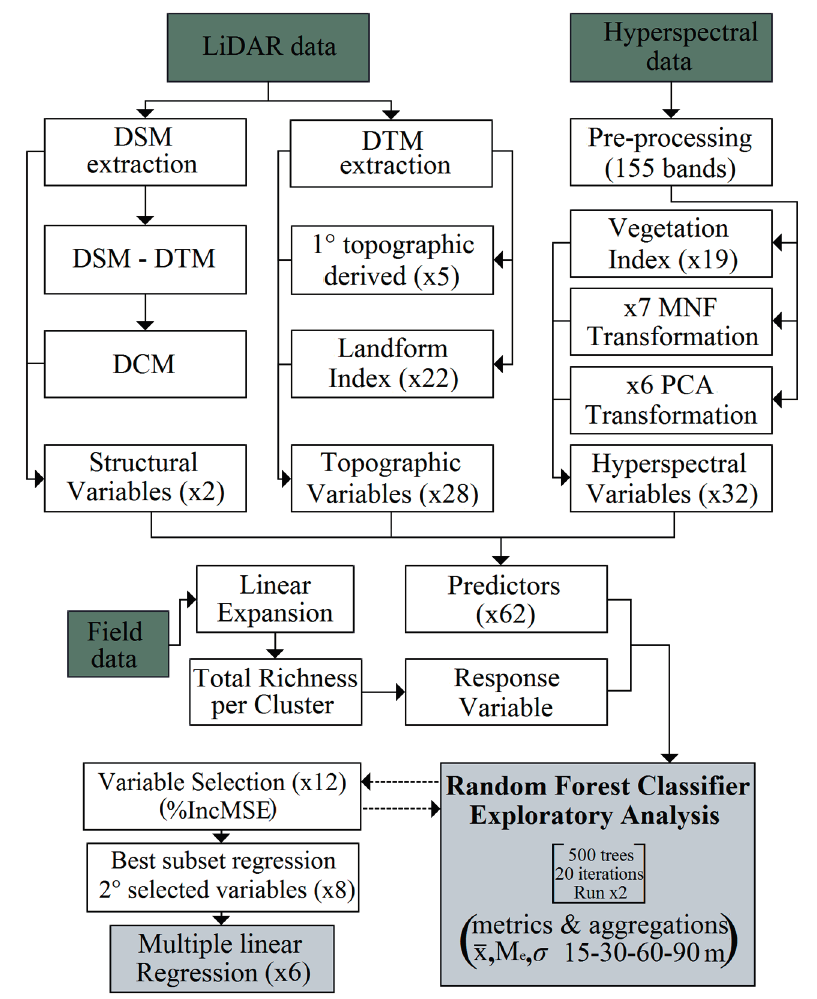
Figure 1. Data processing flow chart to obtain the predictive model of plant